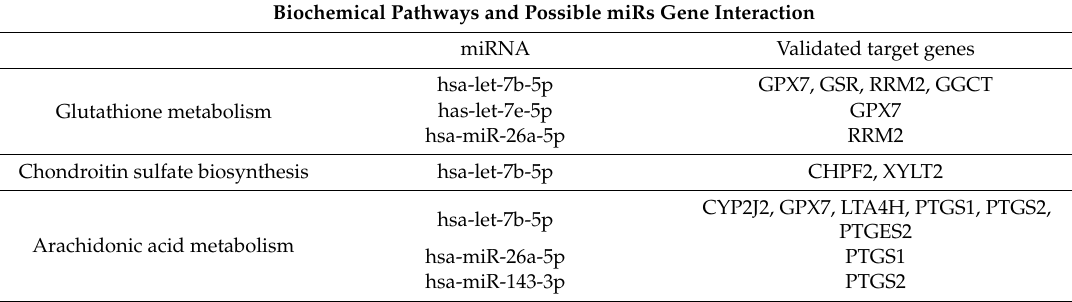
Table 3. Antioxidant metabolism and inflammatory-related